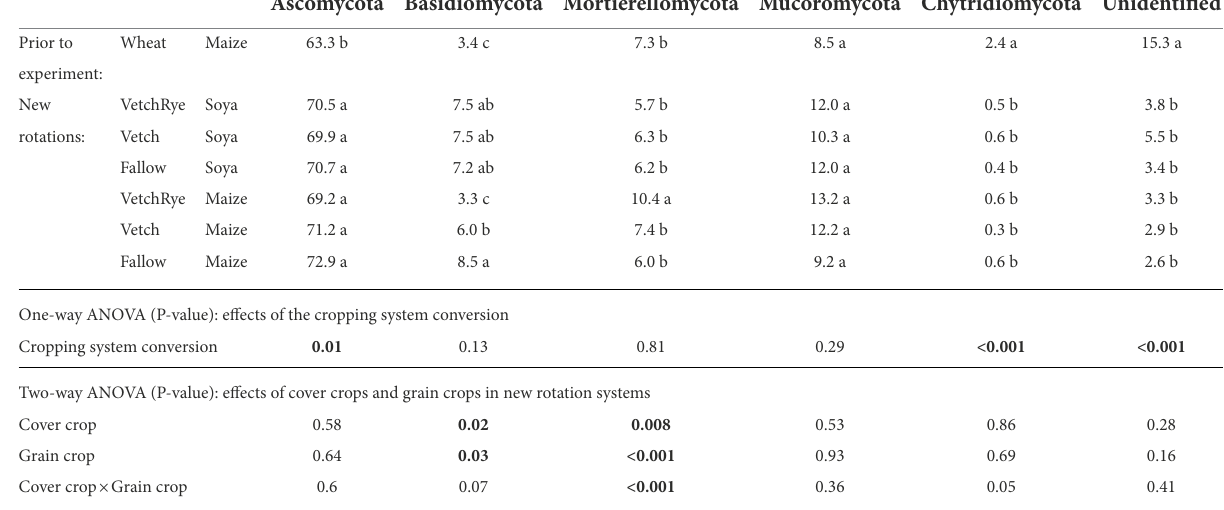
Lowercase letters indicate significant differences among the crop rotation systems in volumes at p ≤ 0.05. Bold numbers indicate significant effects at p ≤